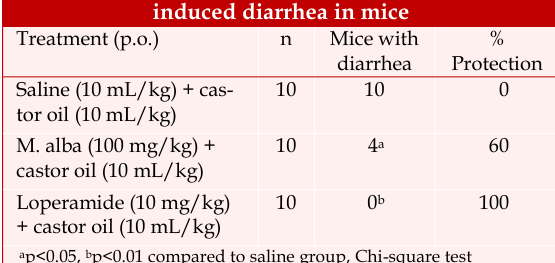
Effect of the crude extract of M. alba on castor oil- induced diarrhea in mice Treatment (p.o.)